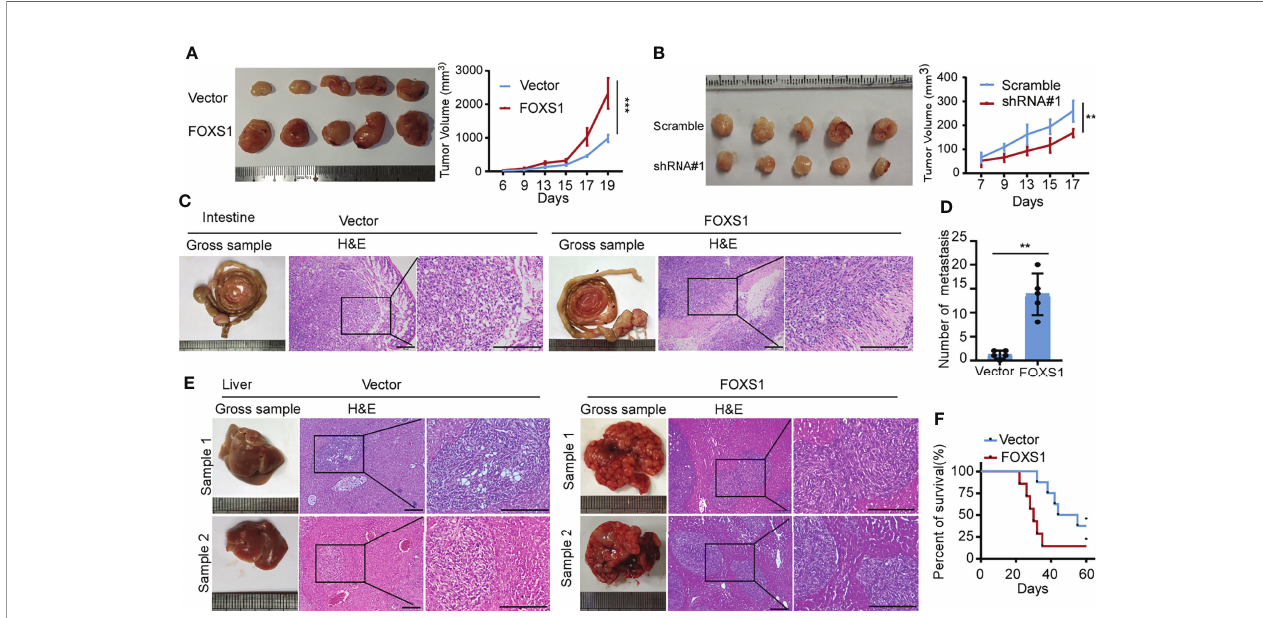
FIGURE 3 | FOXS1 promotes tumor growth and metastasis in vivo. (A, B) An in vivo tumorigenesis experiment was performed by subcutaneous injection in nude mice. The effect of FOXS1 overexpression on SW837 cells (A) or FOXS1 knockdown on HCT15 cells (B) was assessed by evaluating tumor volume (left) and tumor growth curves (right). (C-F) An orthotopic metastatic model was performed by injection of SW837 cells into the cecum. The mice were sacri fi ced when they reached the endpoint criteria (moribund or lost 20% of their pre-experiment body weight). (C) Representative gross images of the intestines are shown (left). Intestine sections were stained with hematoxylin and eosin (H&E, right). Scale bars: 100 µm. (D) The statistical analysis of the number of liver metastatic nodules. (E) Representative gross images of the livers and H&E staining for tissues are shown, and livers are shown (left). Intestines and liver sections were stained with hematoxylin and eosin (right). Scale bars: 100 µm. (F) The Kaplan – Meier method was used to analyze survival curves in the two groups, and the log-rank test was used to compare differences. ** p < 0.01, *** p <